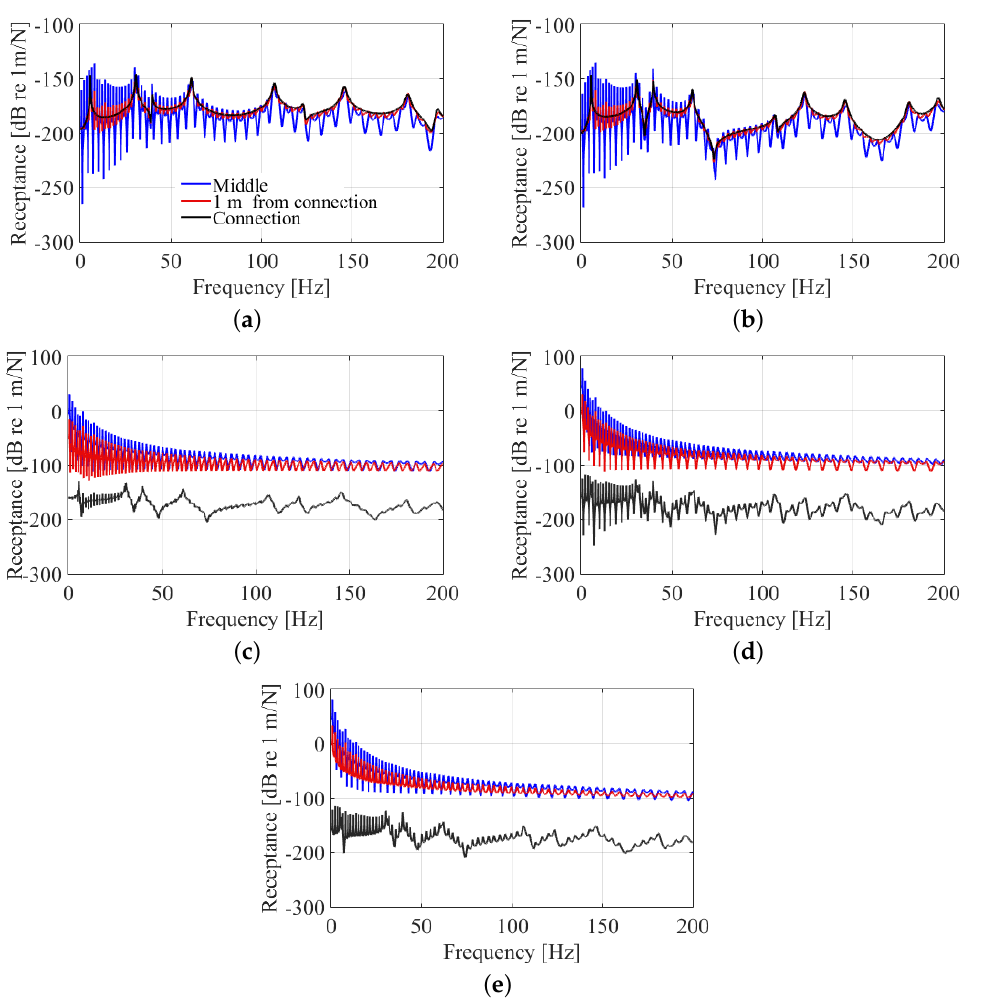
Figure 16. FRF s obtained due to an unitary excitation force positioned at the coupling point ‘b‘ (black curves), a meter from the connection in ‘c‘ (red curves), and at the cable middle length in ‘d‘ (blue curves), and estimated at: ( a ) tower, ( b ) tower-cable connection, ( c ) Cable 1 m from support, ( d ) Cable middle length, ( e ) cable